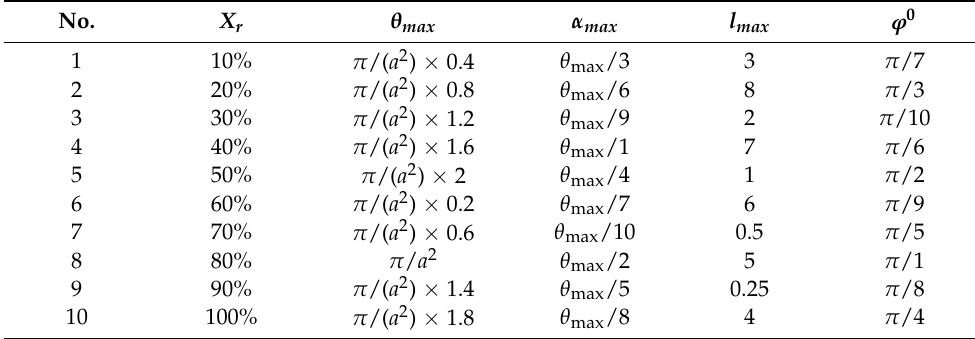
Table 7. The U 10 (10 5 ) uniform layout for the GSO